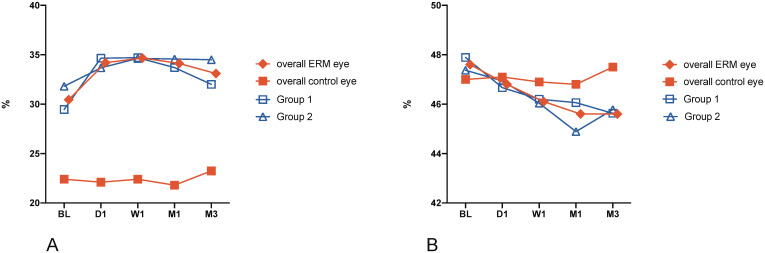
Vessel density (VD) of the superficial retinal plexus was assessed in ETDRS grid locations 1 to 5.(A) VD of the foveal and centermost ETDRS location 1 (VD1); (B) Mean VD of the parafoveal and surrounding ETDRS subfields 2–5 (VD2-5), representing the inner circle of the ETDRS grid. Data are presented as mean; BL = baseline, W1 = week 1, M1 = month 1, M3 = month 3; Group 1 = ERM stages 1 and 2; Group 2 = ERM stages 3 and 4.